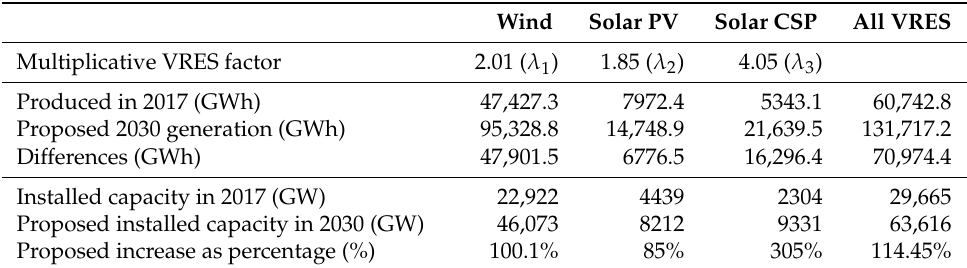
Table 2. First row: The multiplicative factors for each renewable. Following rows: The comparative yearly generation and installed capacity of VRES. Source: Authors. Data: The results from the optimization analysis in Model